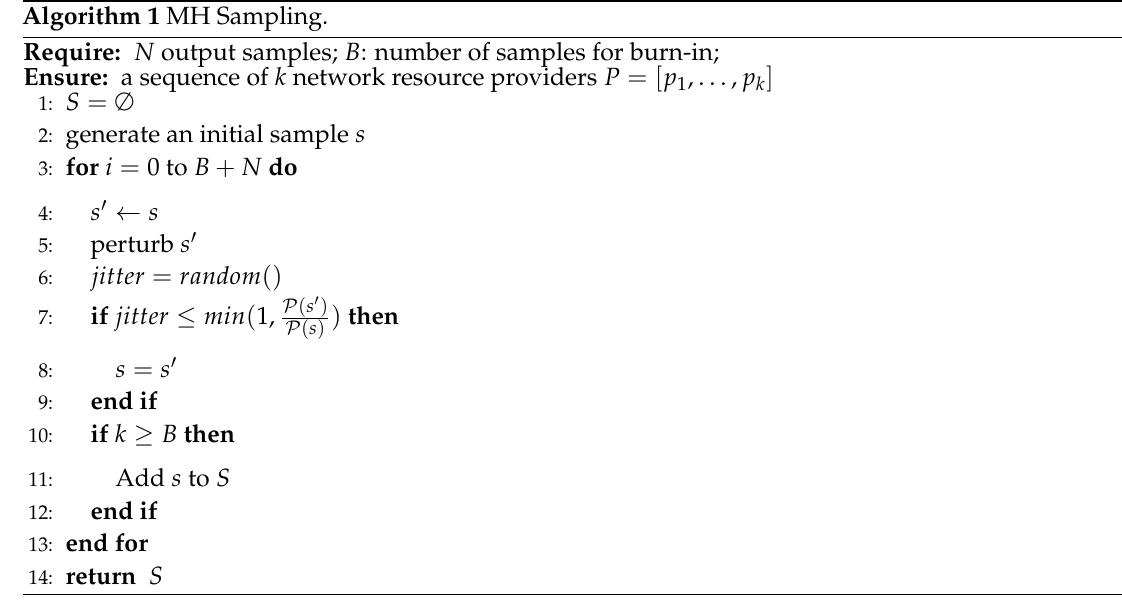
Algorithm 2 Algorithm for Best Search